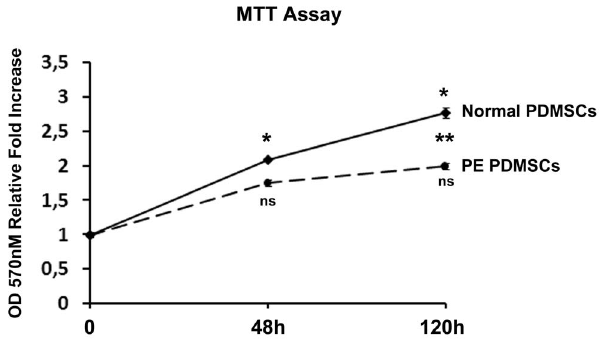
Figure 1. Cell proliferation rate in Normal and PE-PDMSCs. Cell proliferation in Normal and PE-PDMSCs was assessed by MTT assay at time 0, 48 and 120 hours of culture. Results are expressed as means 6 SE of six independent samples. Statistical significance has been considered as p , 0.05. (*)=statistical significance among Normal PDMSCs time points; (**)=statistical significance between Normal and PE-PDMSCs at 120 hours of culture. (ns)=not statistically significant, referred to comparisons among PE PDMSCs time points.